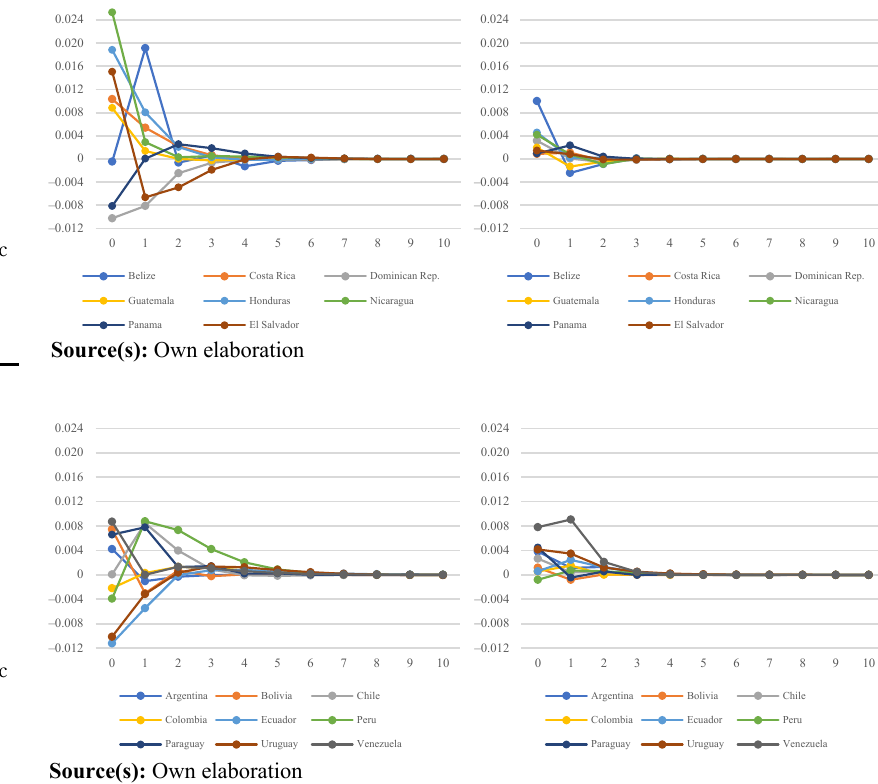
Figure 6. Response of domestic output to a global shock in SA, 1960 – 2000 (left), 2001 – 2018